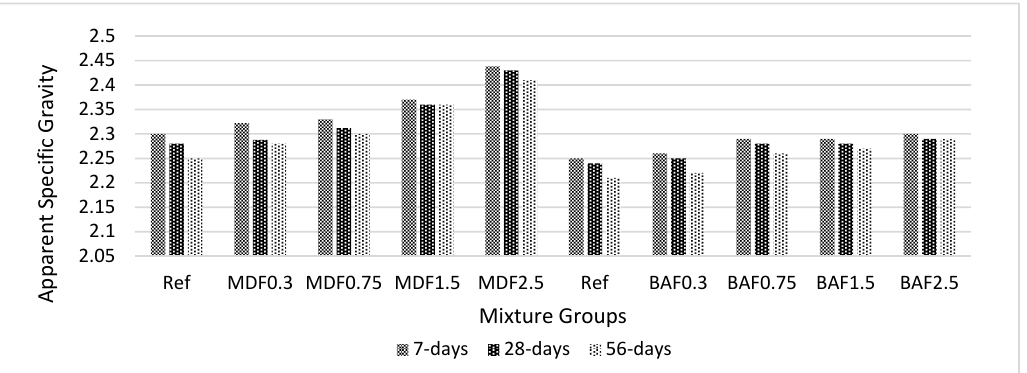
Figure 5. Effect of carbon fibers on apparent specific gravity for marble dust and bottom ash mixture groups at 7, 28 and 56 days of curing.